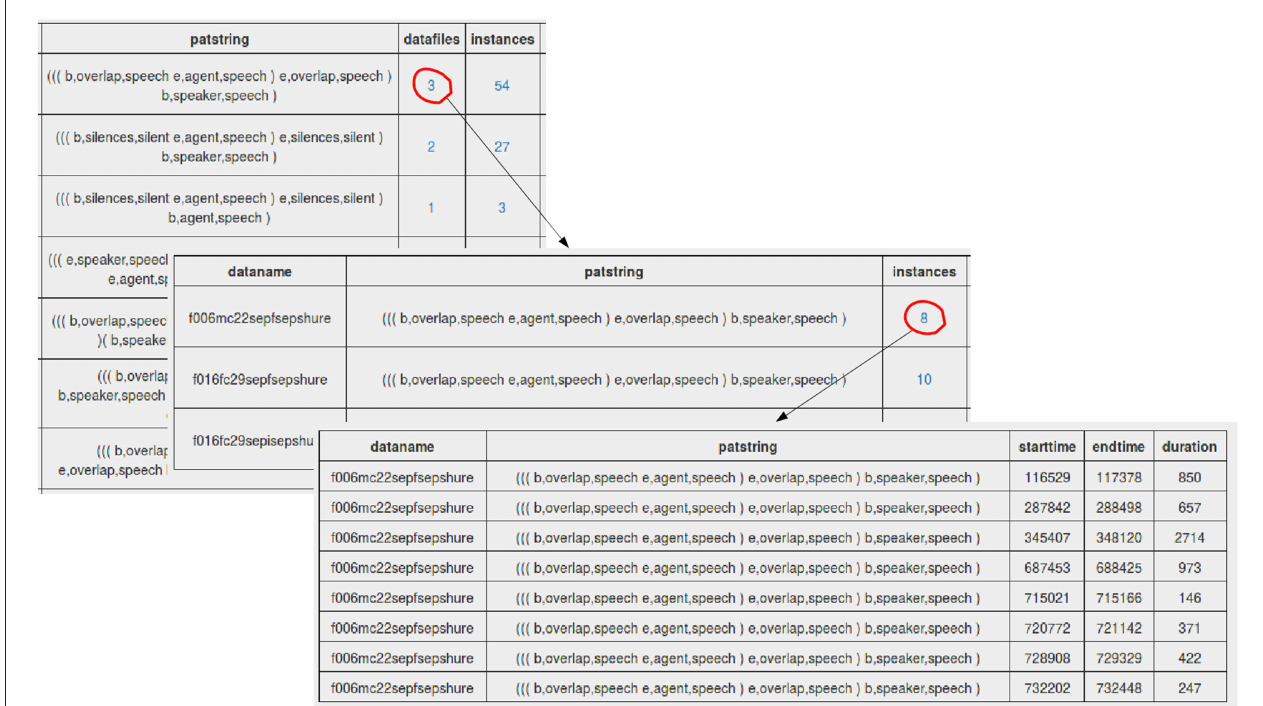
FIGURE 8 | Sequence of database queries: based on the resulting table of T-patterns, one can check the datafiles for a particular pattern, then the exact locations (timing properties) inside that